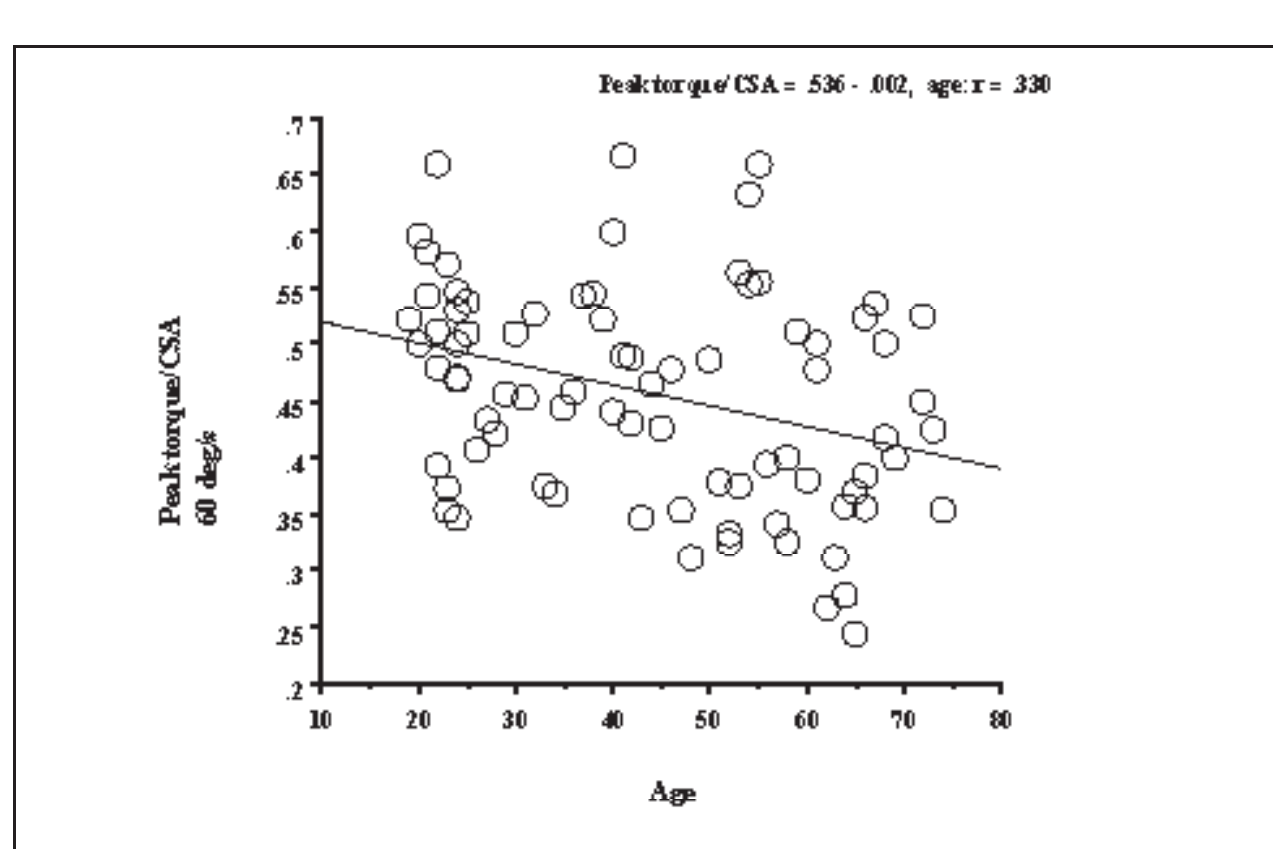
Fig. 5(A): The peak torque / CSA ratio and aging were less significantly correlated in both the angular velocities. (A: 60 deg/s angular velocity, r = 0.330, p <0.0026)